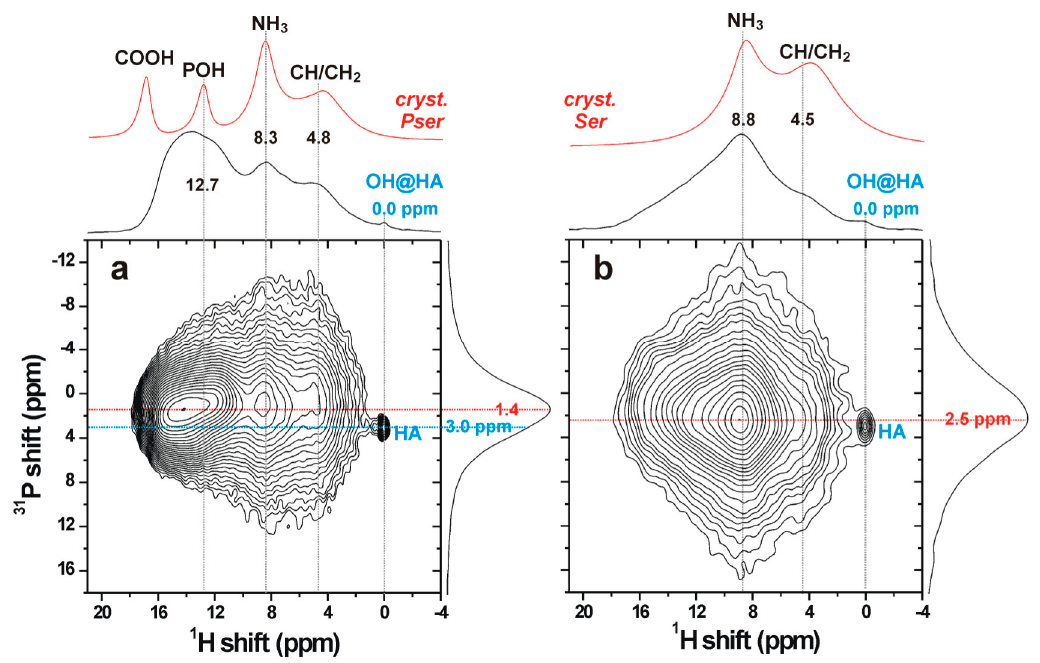
Figure 6. ( a , b ) 1 H{ 31 P} D-HMQC NMR spectra recorded from cements incorporating 16 mol% of ( a ) O-phospho-L-Serine and ( b ) L-serine. NMR signals are only detected from 1 H and 31 P nuclei in close spatial proximity (<0.5 nm), where each proton resonance (at chemical shift δ H ), appearing along the horizontal dimension of the 2D NMR spectrum, is correlated with its respective 31 P NMR signal (at chemical shift δ P ) along the vertical spectral dimension. Projections along the 1 H and 31 P dimensions are shown at the top and to the right of each 2D NMR spectrum, respectively, whereas the topmost red traces represent 1 H magic-angle-spinning (MAS) NMR spectra recorded directly by single pulses. The 2D NMR spectra from both the phosphoserine and serine cements confirm that all detected signals originate from amorphous organic/inorganic components, except for a minute (<1% of the total integrated intensity) and narrow peak (labeled “HA”) at the shift-coordinate { δ P , δ H } = {3.0, 0.0} ppm, which stems from well-ordered hydroxyapatite.